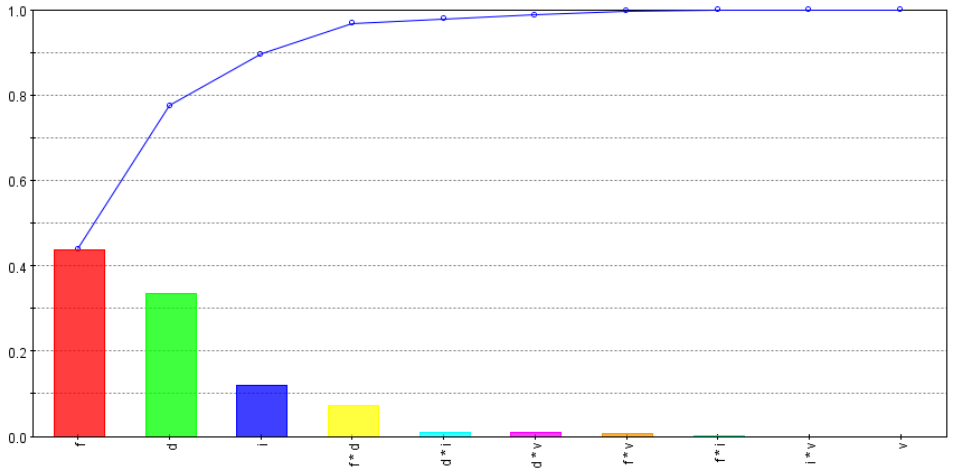
Figure 9. Specific-cutting-energy dependencies on input variables and their interactions.